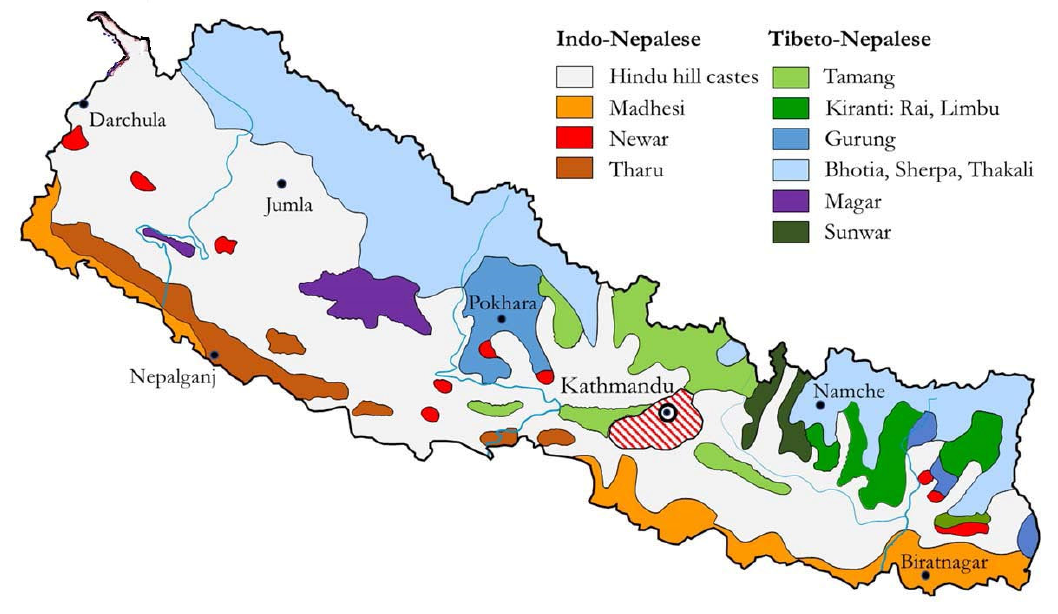
Figure 7. Agro-ecological belt-wise distribution of main ethnic groups in Nepal [Source: [133]]. Government bureaucrats have intensified their presence and officials’ interventions in the communities where forest resources and wild animals are enriched. Military posts